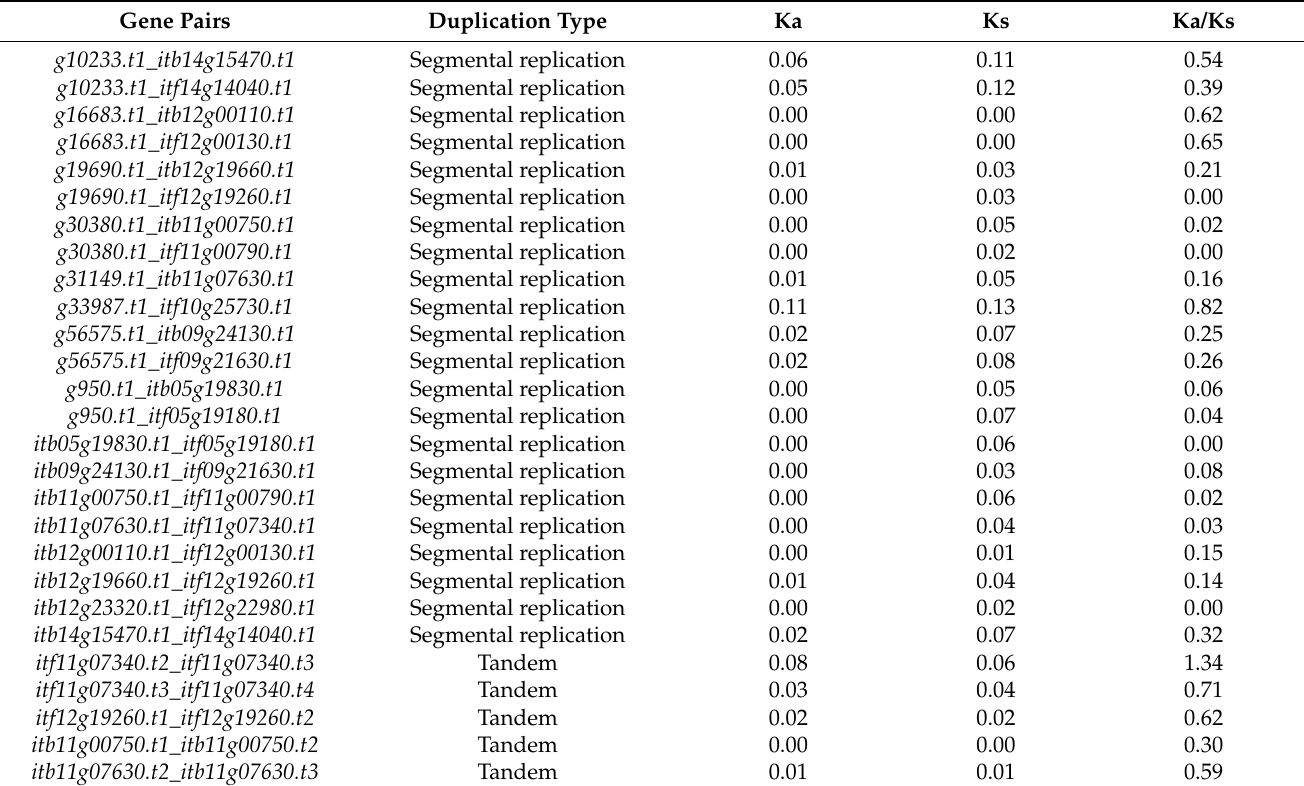
Table 2. Ka/Ks analysis of the duplicated and syntenic nifH genes in and between the three Ipo- moea